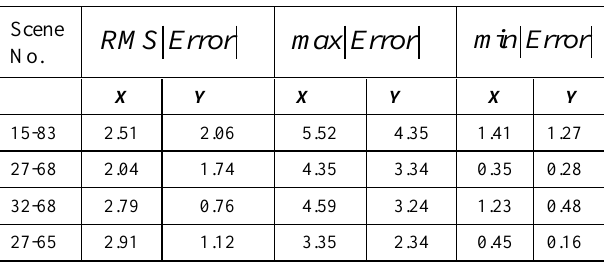
Table 1. Compare of experimental consuming time